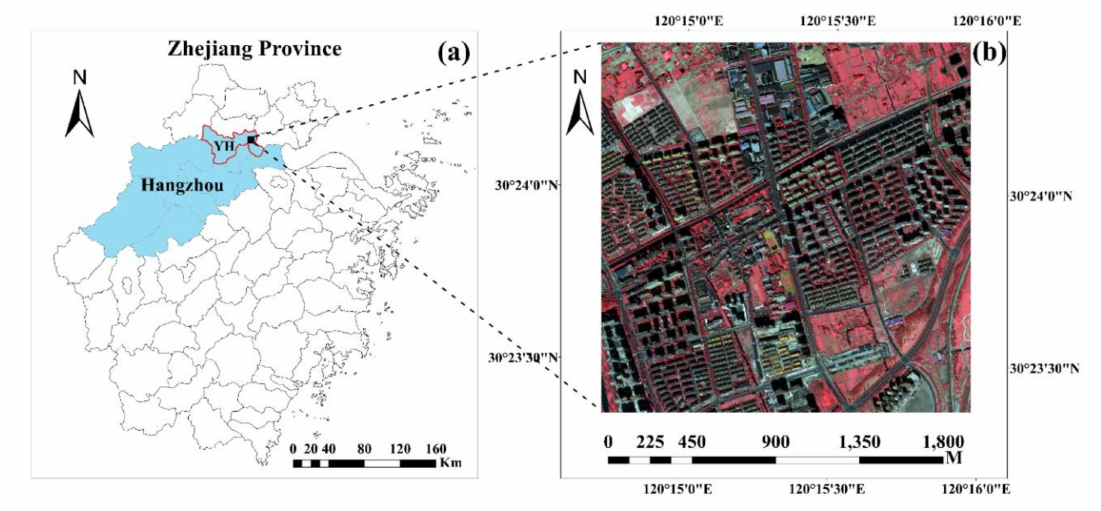
Figure 1. Location of the study area: ( a ) Zhejiang Province, and the blue polygons represent Hangzhou, ( b ) the subregion of the Yuhang District (YH) of